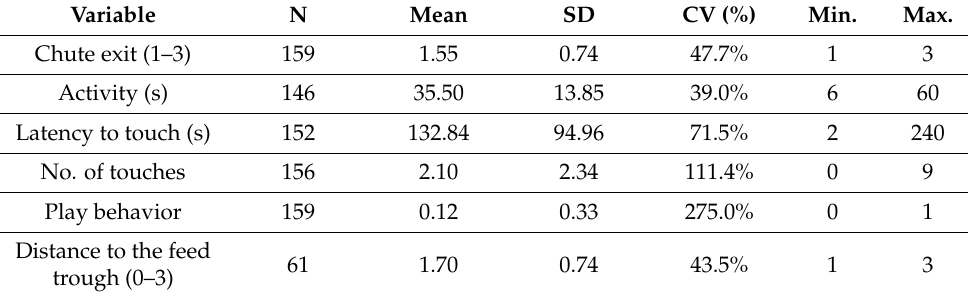
Table 3. Descriptive statistics of some of the parameters